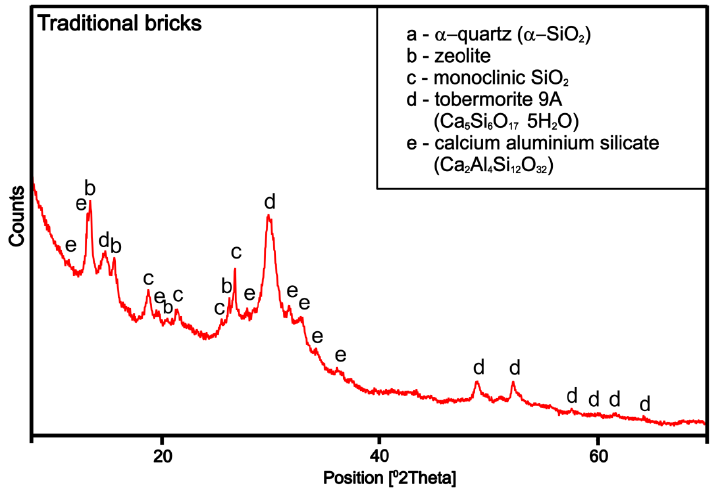
Figure 11. XRD of reference sand-lime sample containing QS [64].